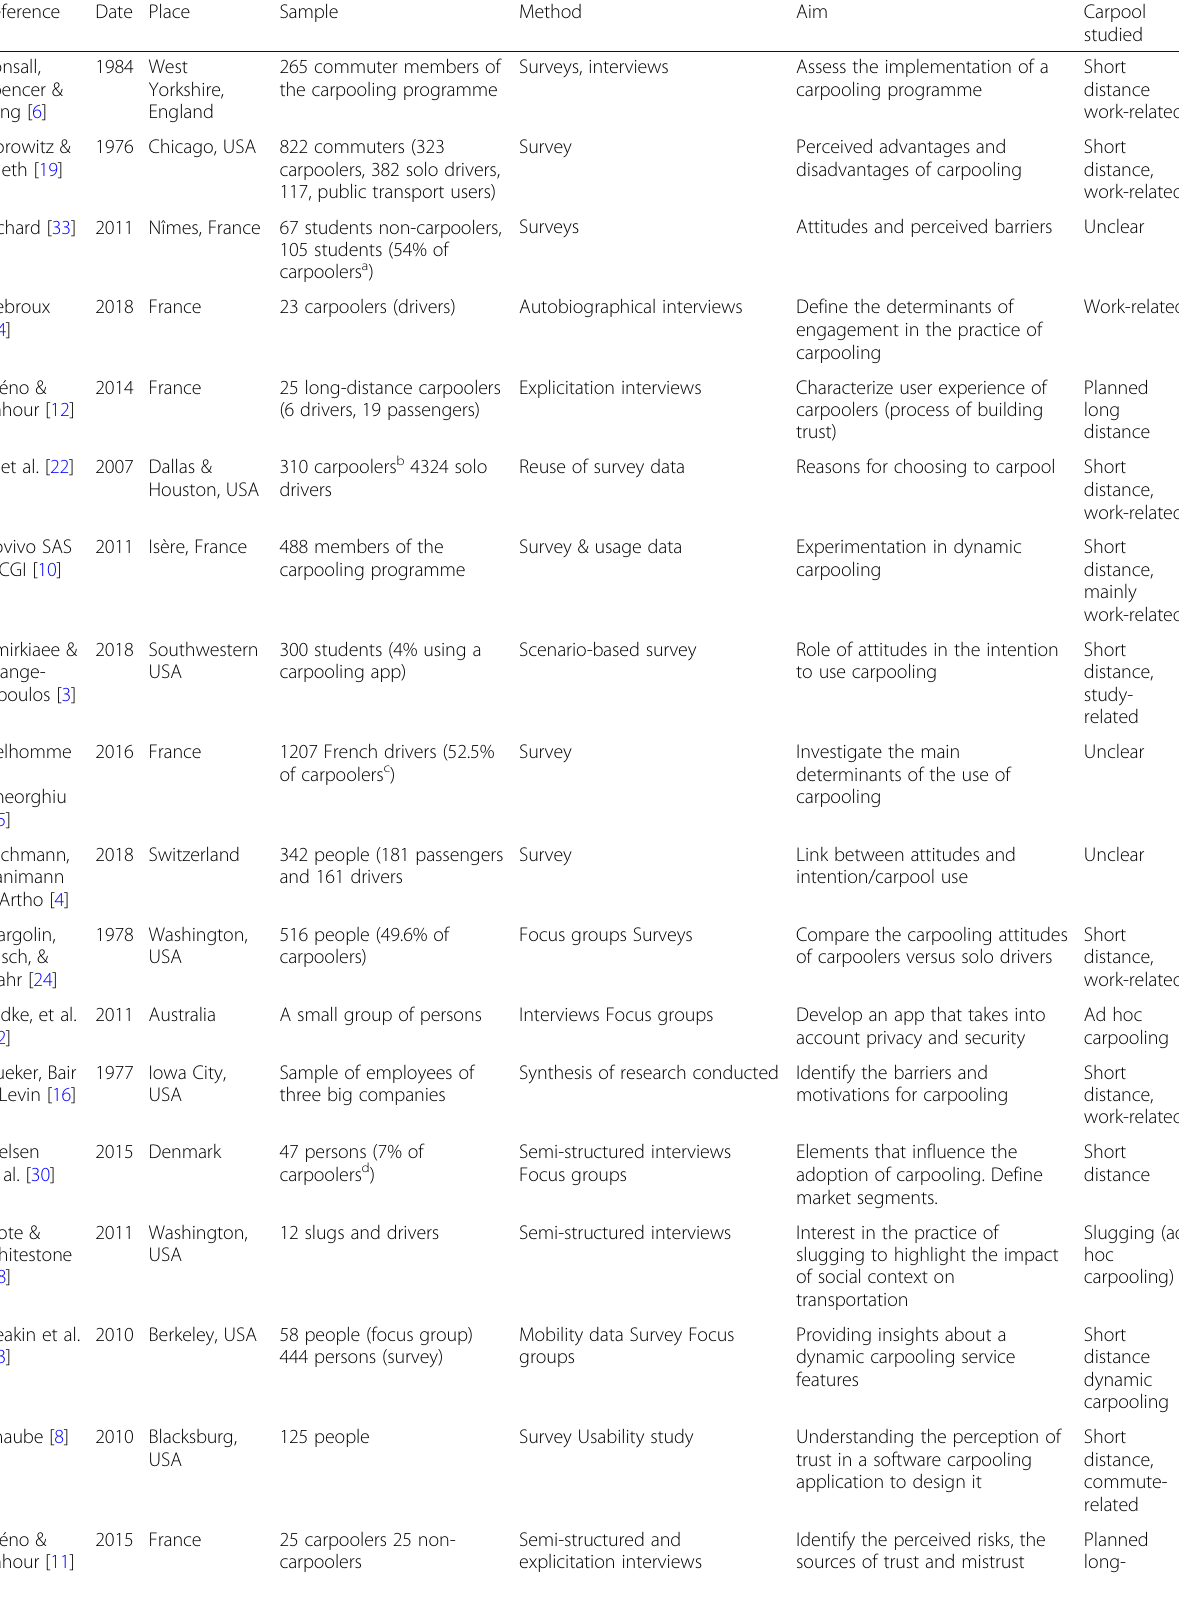
Table 1 Summary of the considered literature about carpooling (in the text below by order of appearance)